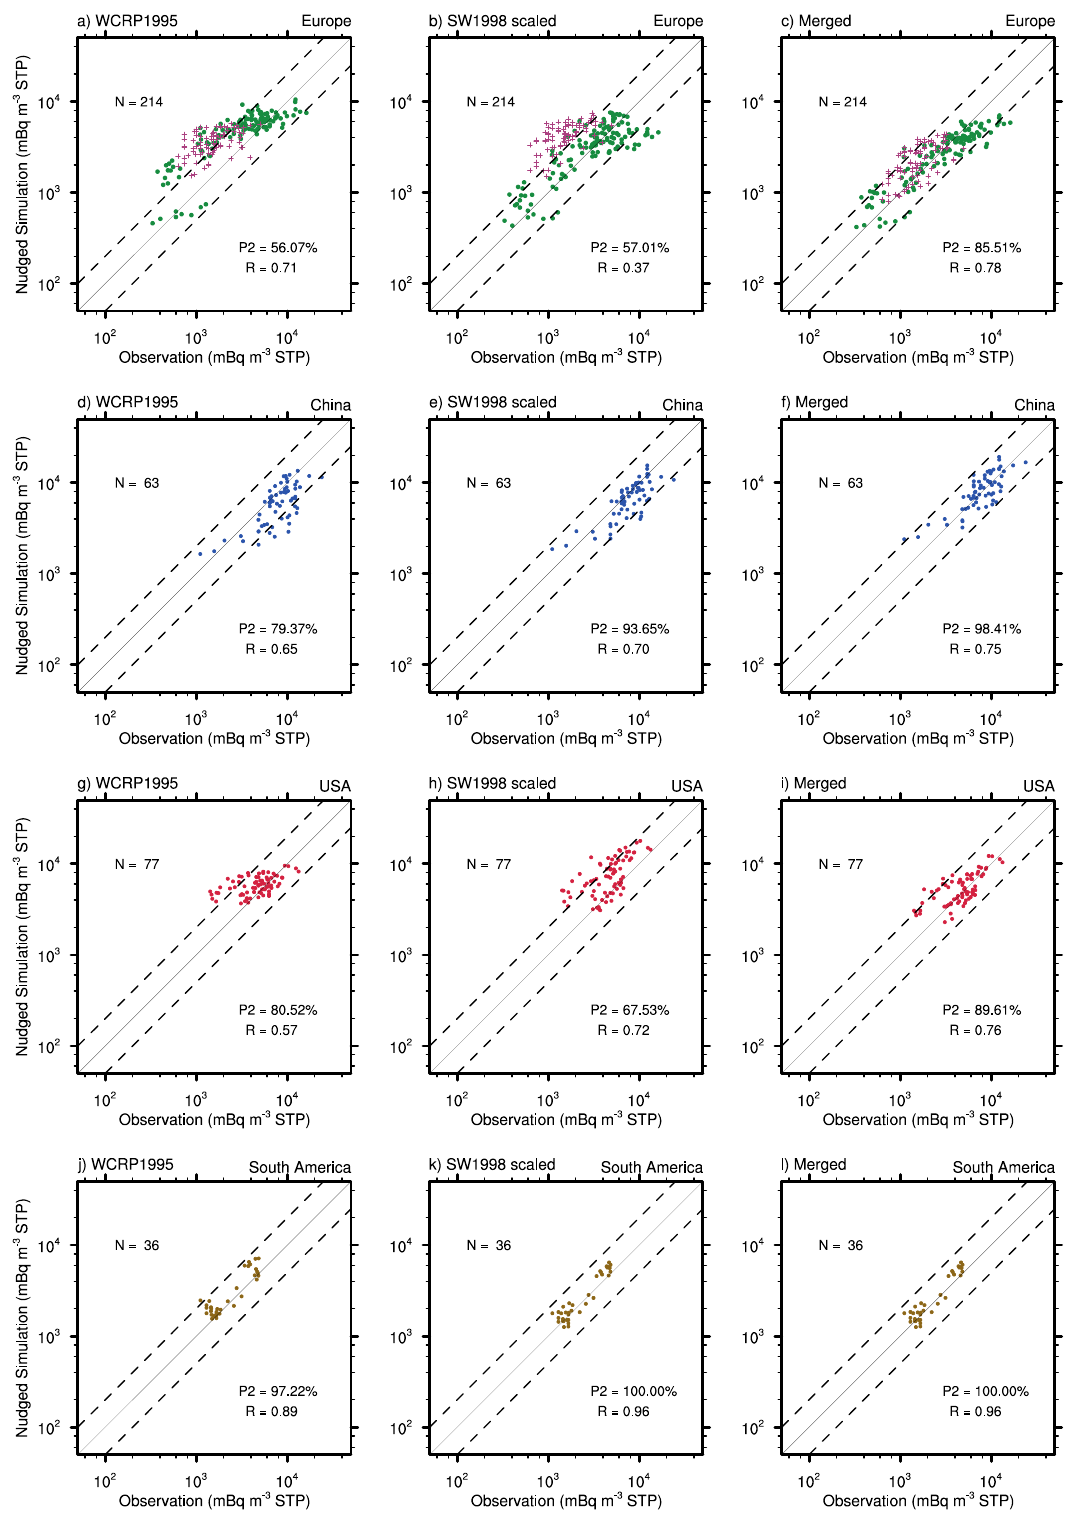
Fig. 5. Same as Fig. 4, but focusing on different regions. The four rows show results in (from top to bottom) Europe, China, the United States and South America. All seasons are included. The marker colors are consistent with Fig. 3.